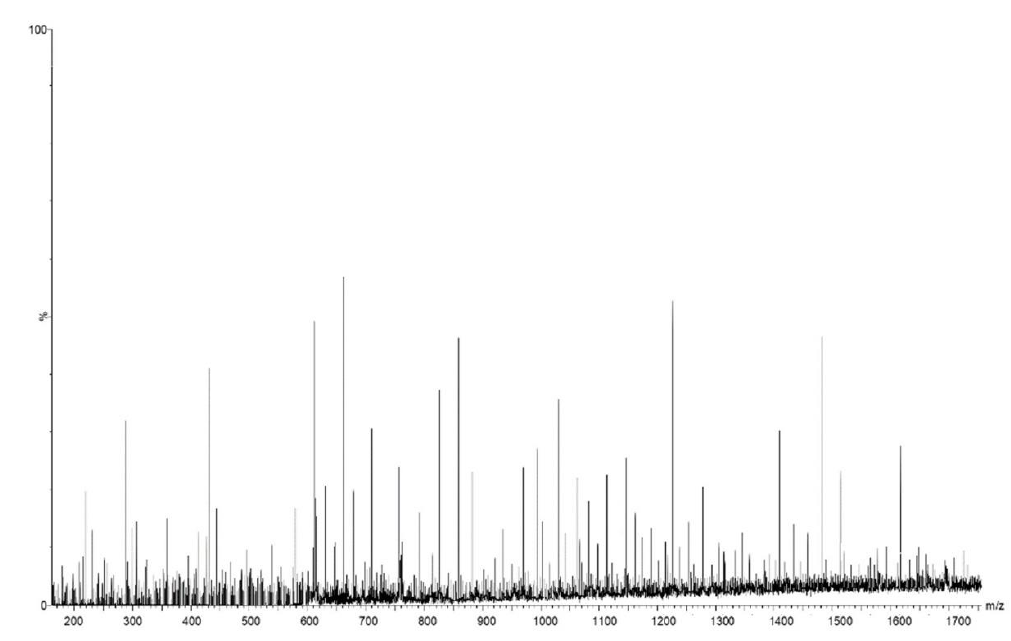
Figure 2. The mass spectrum of Curcuma longa. Table 2. The metabolites identified through electrospray ionization-quadrupole time-of-flight mass spectrometry (ESI-QTOF-MS) analysis.